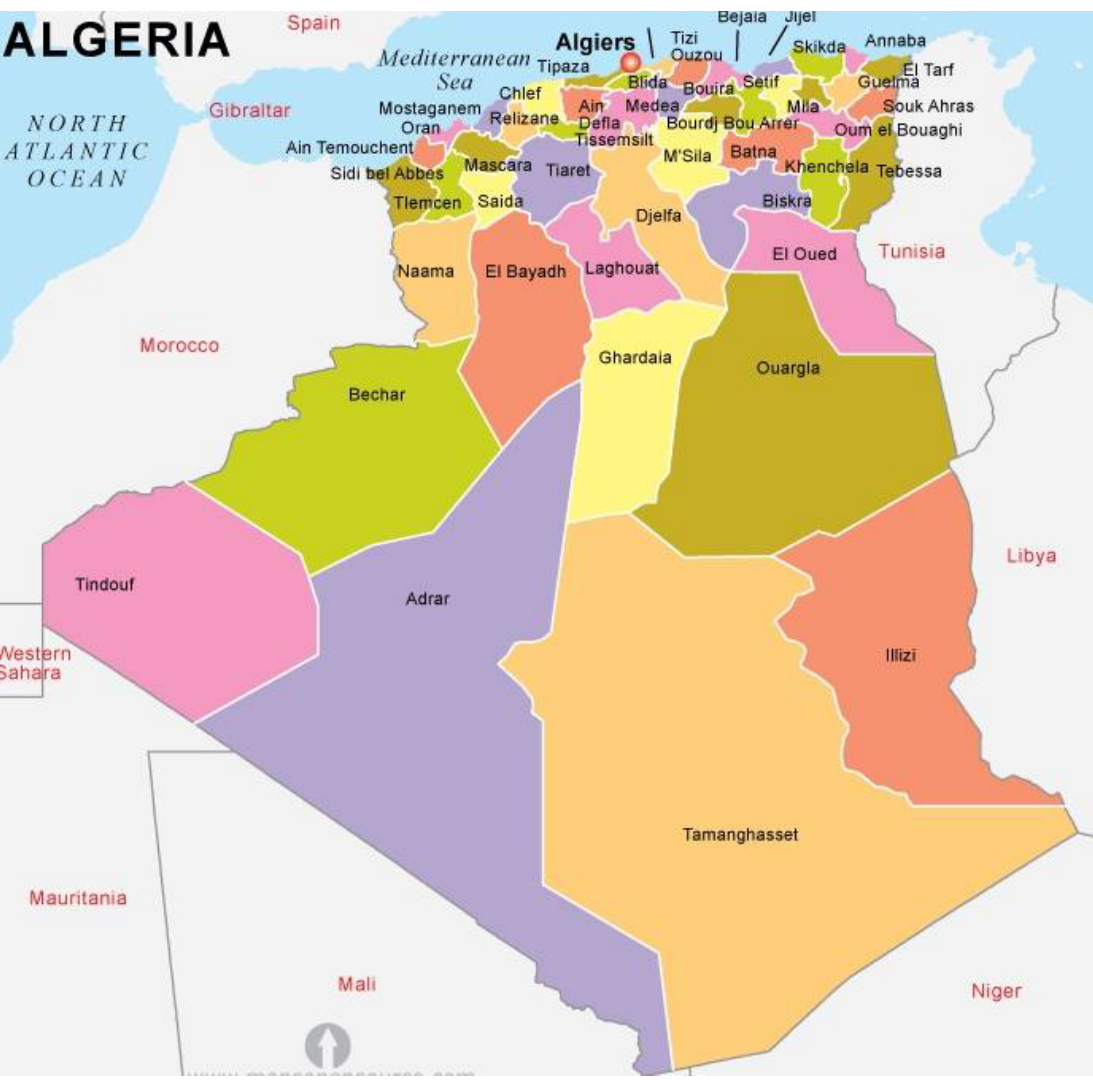
Figure 9. Geographic map of Algiers city [38].